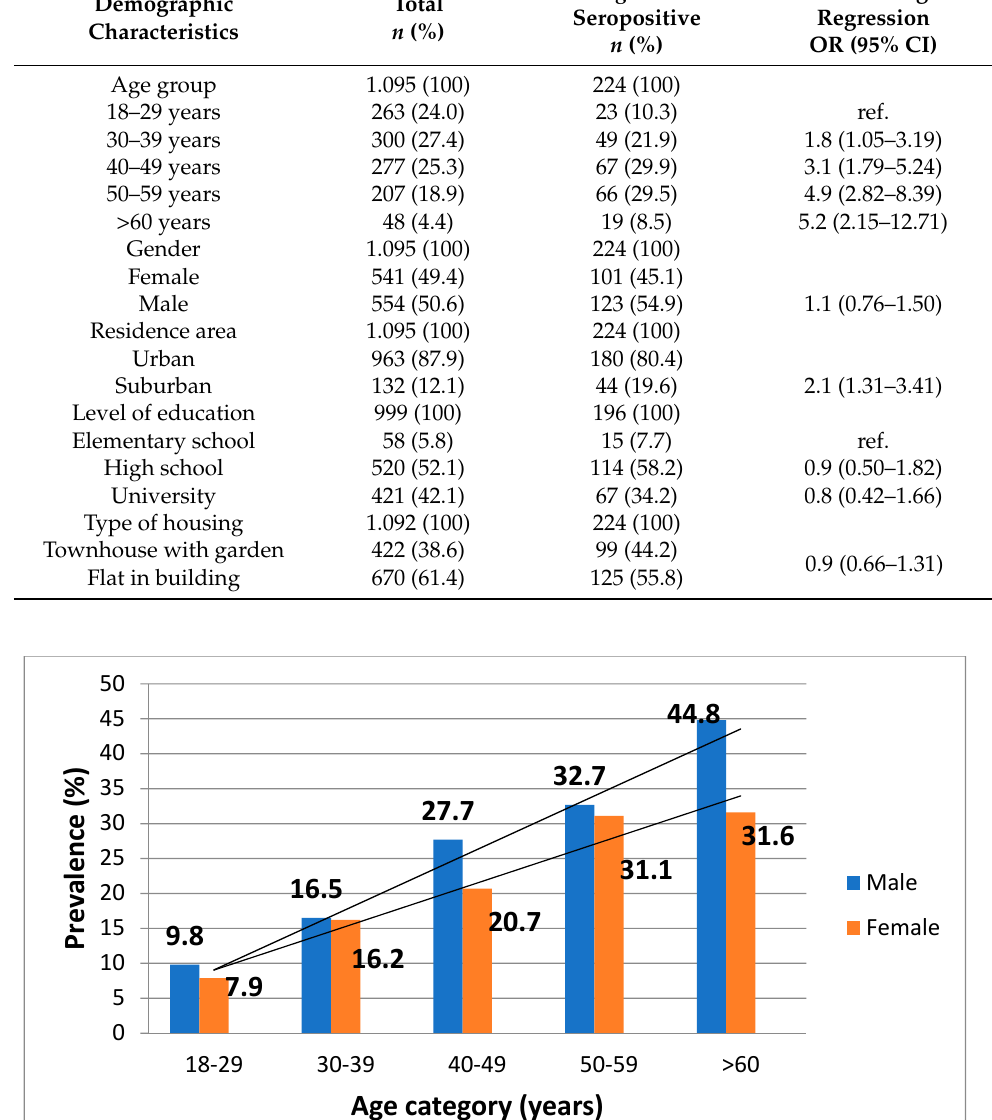
Table 2. Lifestyle habits of participants and univariate logistic regression for T. gondii infection.